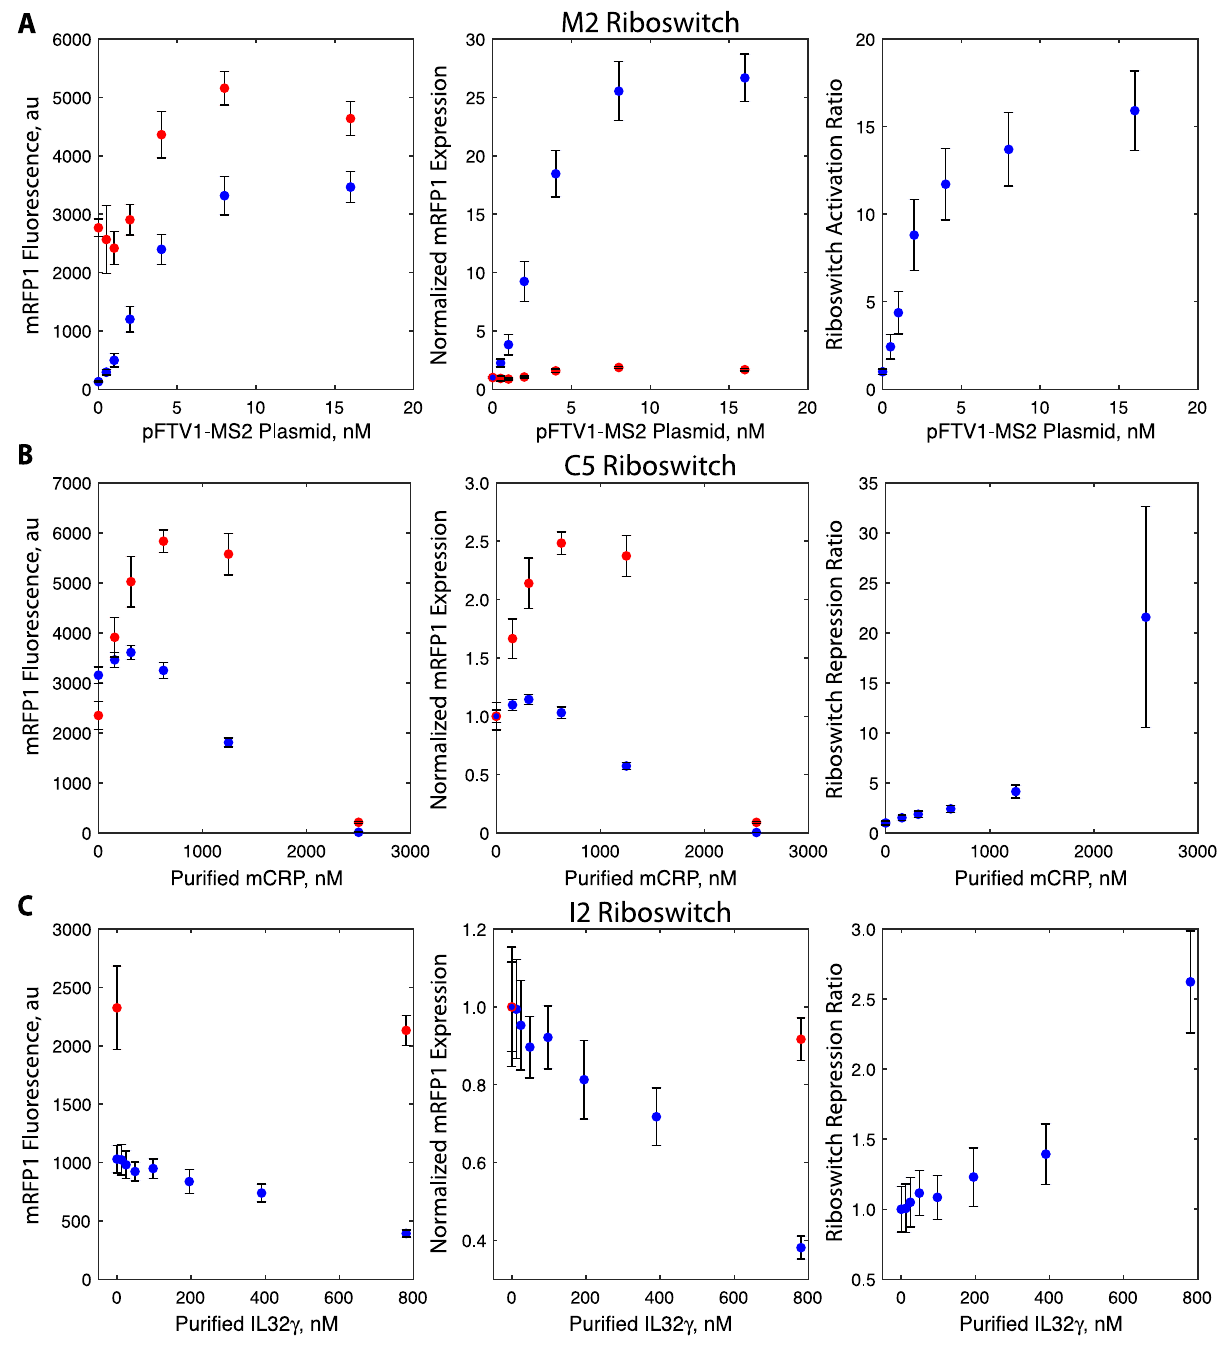
Fig. 4 | Dose – response of MS2, CRP, and IL32 γ riboswitches. The measured mRFP1 fl uorescencelevels,normalizedmRFP1expressionlevels,andactivationor repression ratios of the A M2, B C5, and C I2 riboswitch sensors (blue dots) in response to varied concentrations of the MS2 expression plasmid, puri fi ed human mCRP protein, and puri fi ed human IL32 γ protein, respectively. The